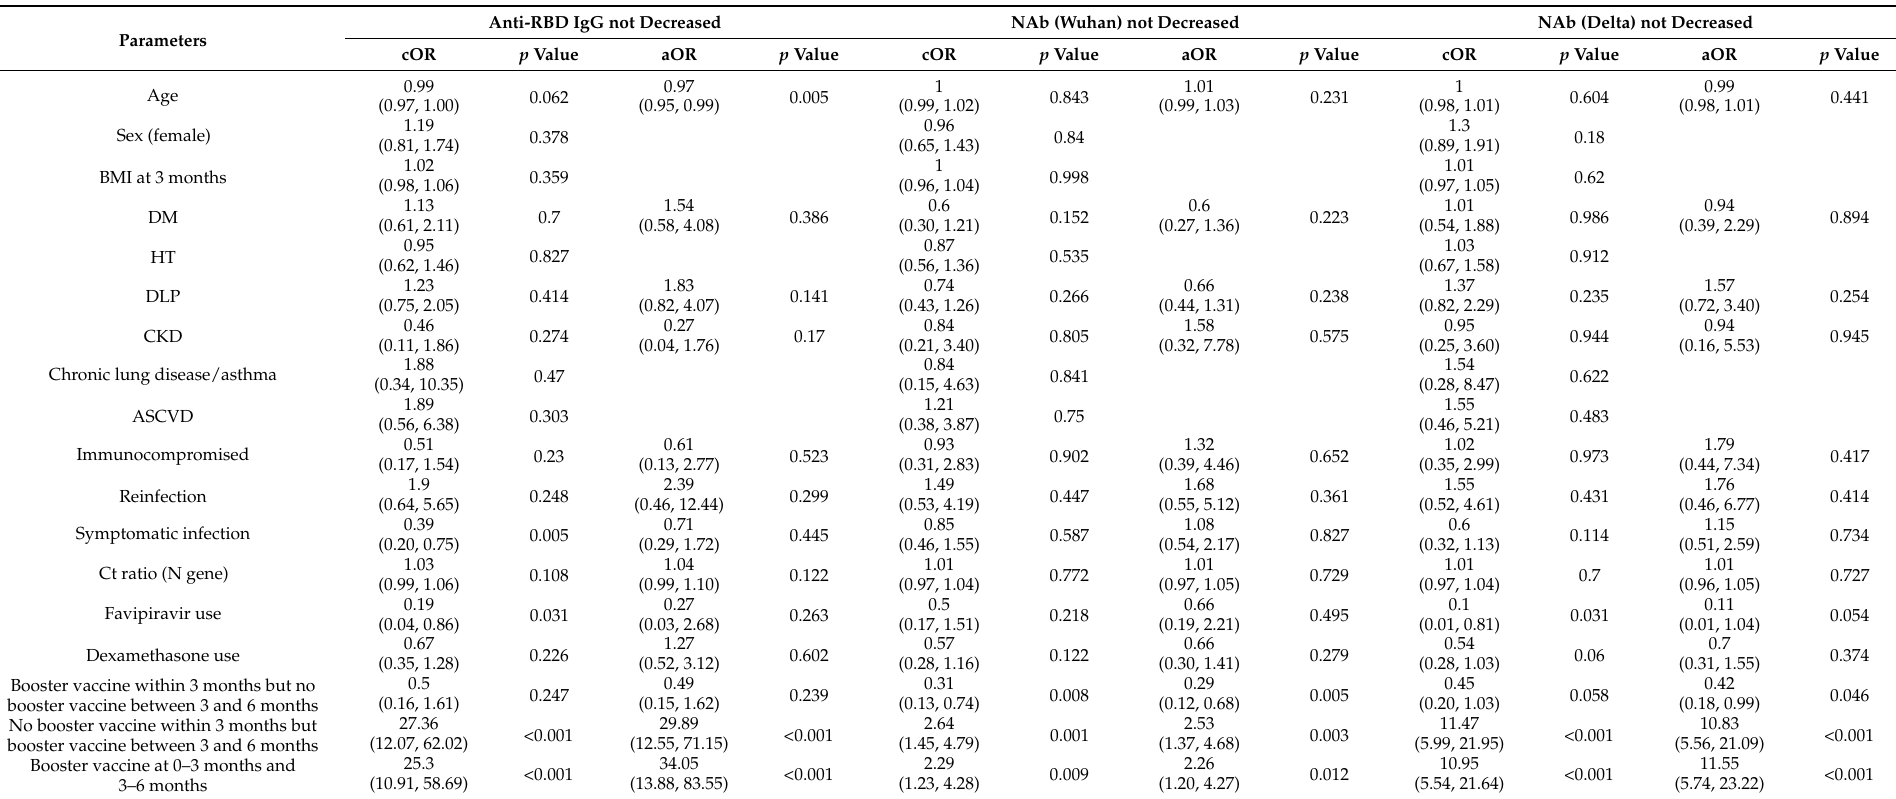
Table 4. Factors associated with immune levels. All association values were evaluated with multivariable logistic regression and are presented as median